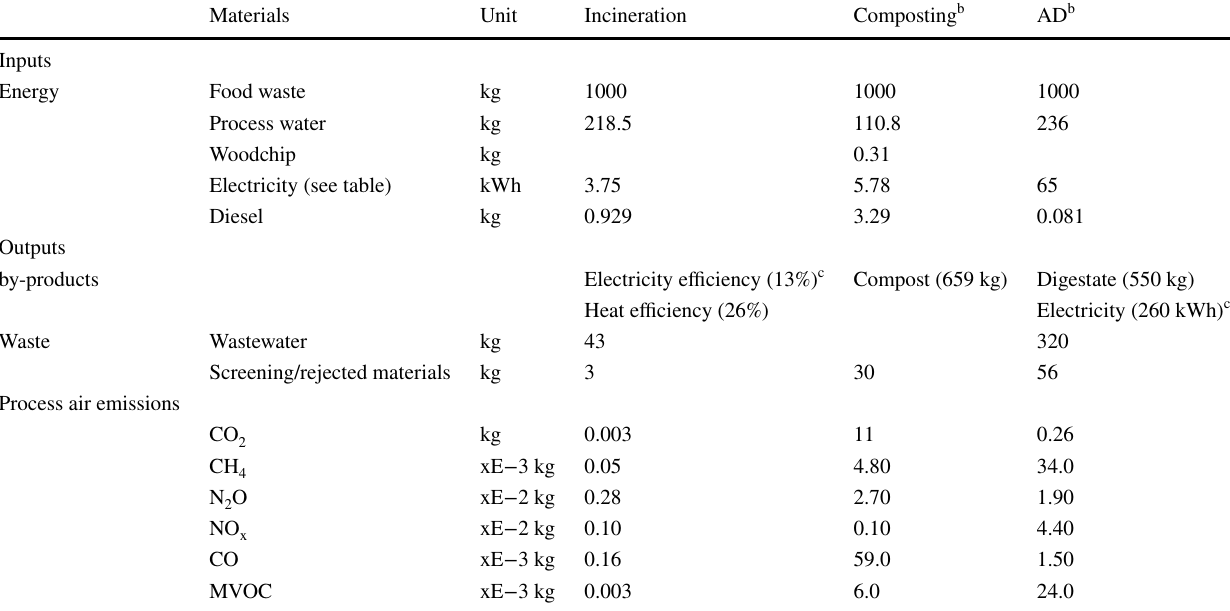
Table 1 Life cycle inventory data of food waste management options